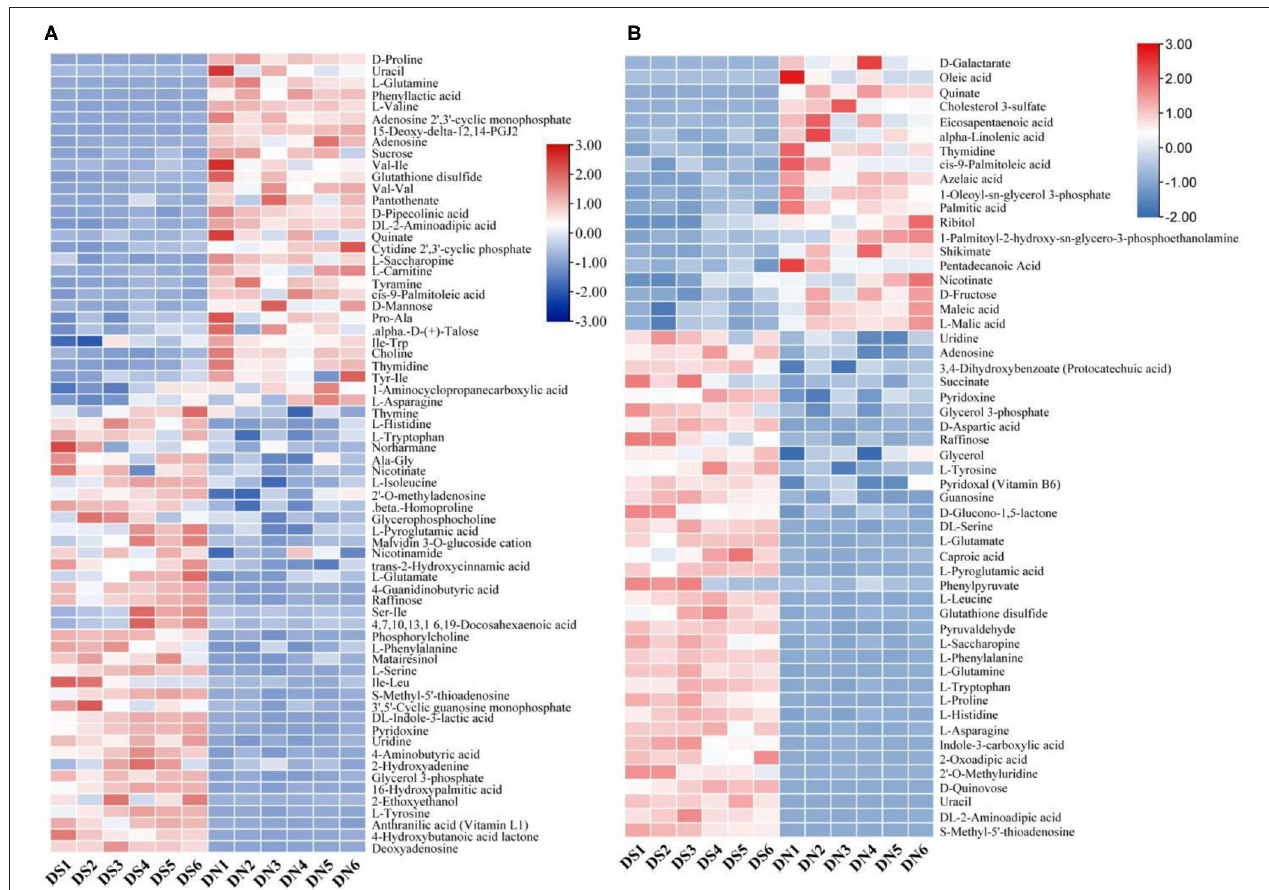
FIGURE 2 | Cluster analysis of a positive ion model (A) and a negative ion model (B) in DN and DS. Red indicates a high expression of metabolites and blue indicates a low expression of metabolites. Columns represent all samples and rows represent all metabolites. DN is DXWR without salt treatment and DS is DXWR under